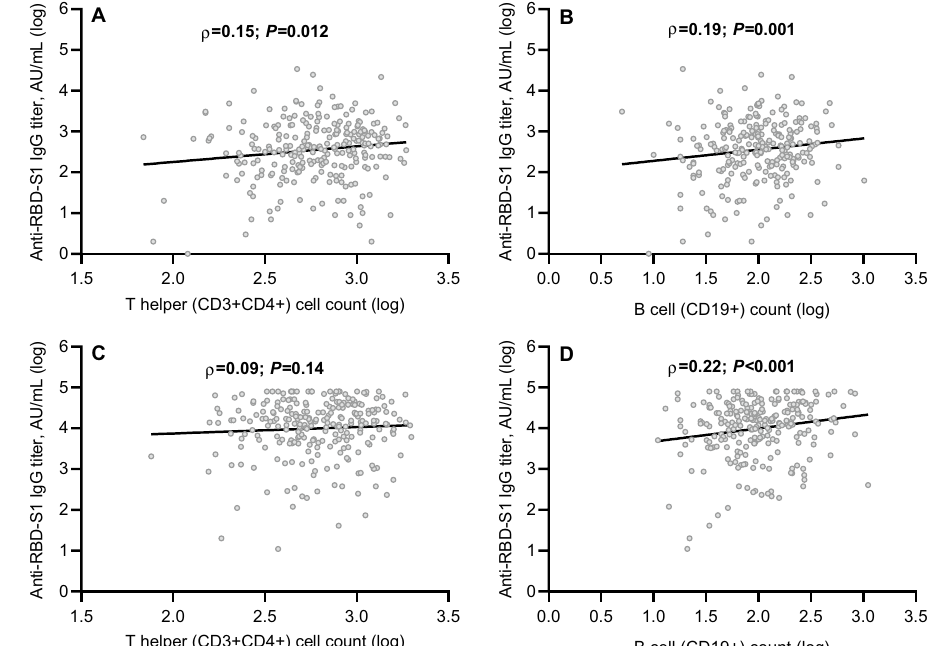
Figure 3. Correlation between antibody titers and lymphocyte subpopulation counts. ( A ) T helper cell (CD3 + CD4 +) counts before the third dose of tozinameran. ( B ) B cell (CD19 +) counts before the third dose of tozinameran. ( C ) T helper cell counts after the third dose of tozinameran. ( D ) B cell counts after the third dose of tozinameran. Correlation was assessed with the Spearman’s test; a two-sided P value < 0.05 was considered statistically significant. RBD-S1, receptor-binding domain (RBD) of the SARS-CoV-2 Spike protein (S1); AU, Arbitrary Unit; log, logarithmic